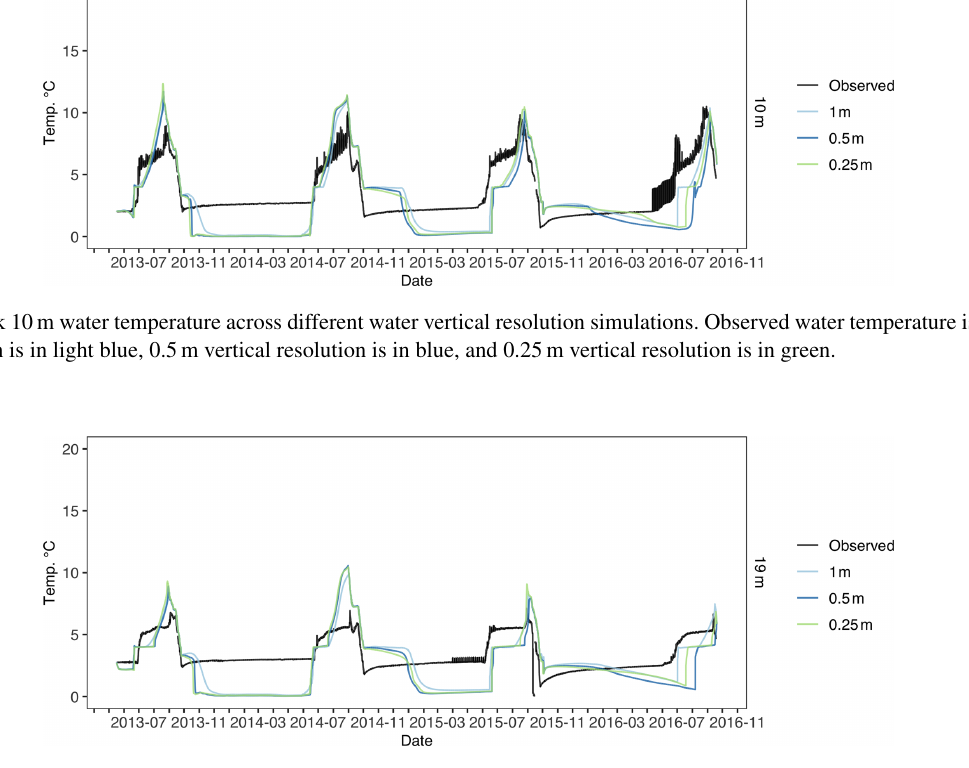
Figure D8. Toolik 19m water temperature across different water vertical resolution simulations. Observed water temperature is in black, 1m vertical resolution is in light blue, 0.5m vertical resolution is in blue, and 0.25m vertical resolution is in green.